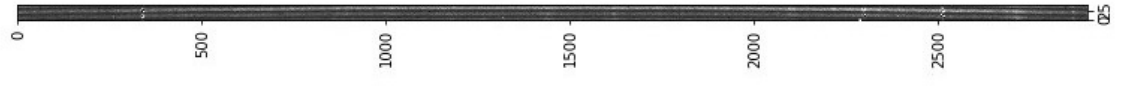
Figure 4. A single 2D spectrum of